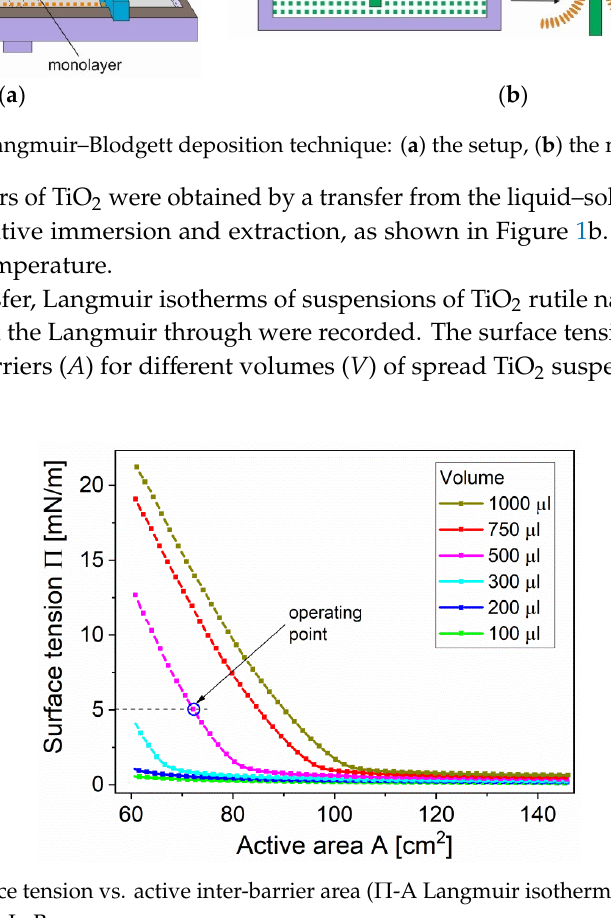
Figure 2. The surface tension vs. active inter-barrier area (  -A Langmuir isotherms) during deposition of TiO 2 thin film by L–B. of TiO 2 thin film by